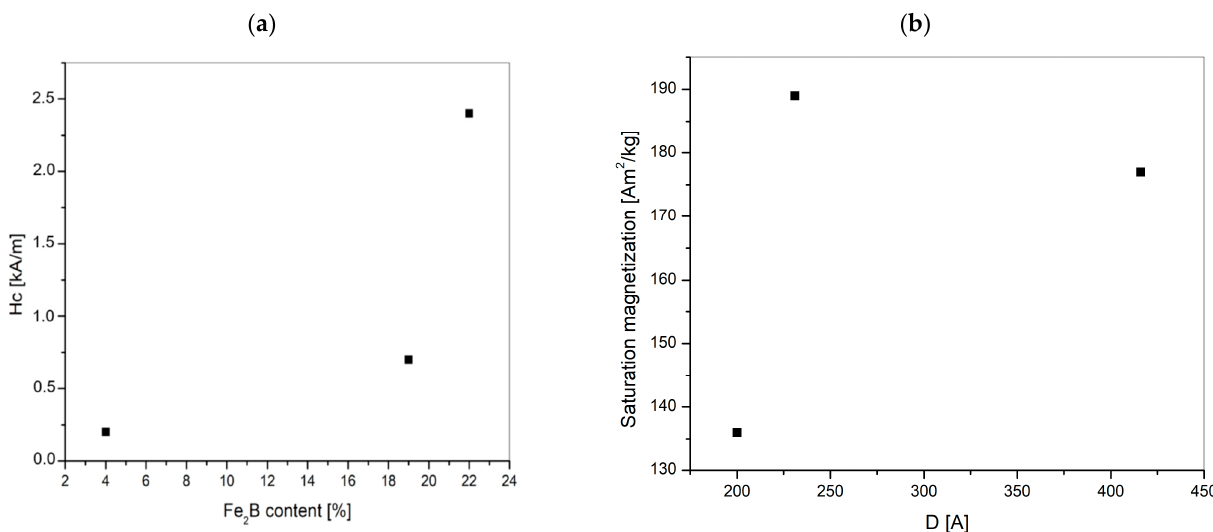
Figure 5. The hysteresis loops of La_2 alloy tape measured at various temperatures: ( a ) 10 K, ( b ) 300 K.